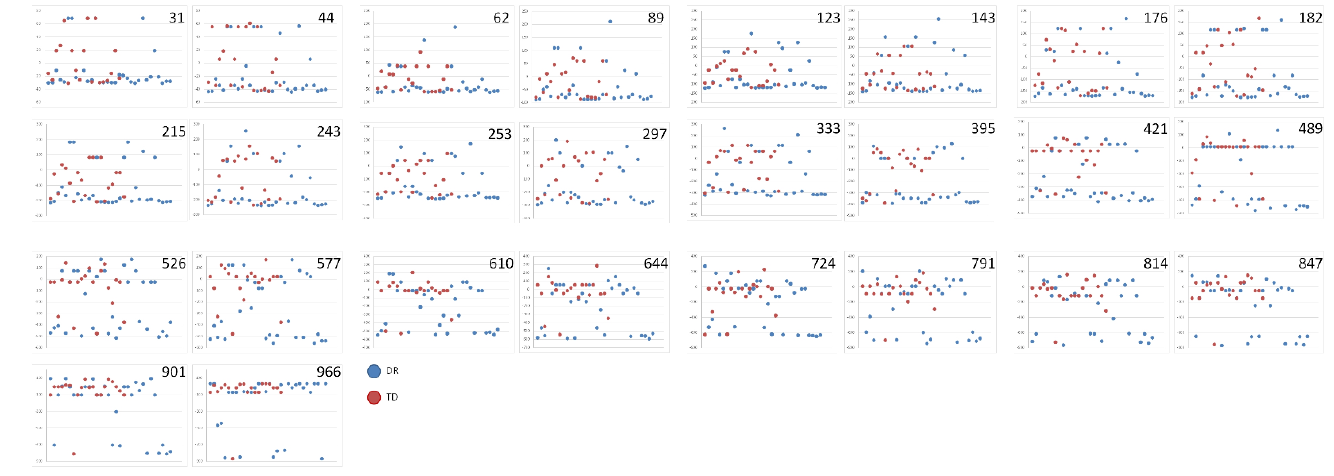
Figure 8. Scatter plots showing the mean EEs calculated for each of the 26 numbers used in the 0 – 1000 verbal task and for each participant. In each plot presenting the results obtained for a particular number magnitude, the dispersion revealed in the DR group is presented in blue, and that in the TD group is presented in red .